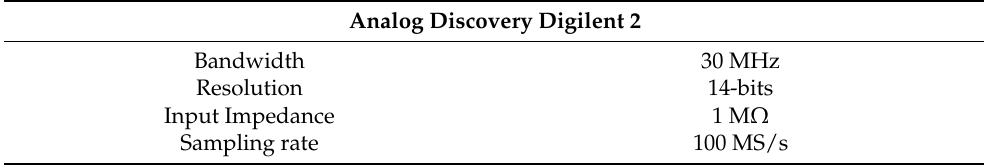
Figure 2. Impedance measurement circuit. Table 1. Analog Discovery Digilent 2